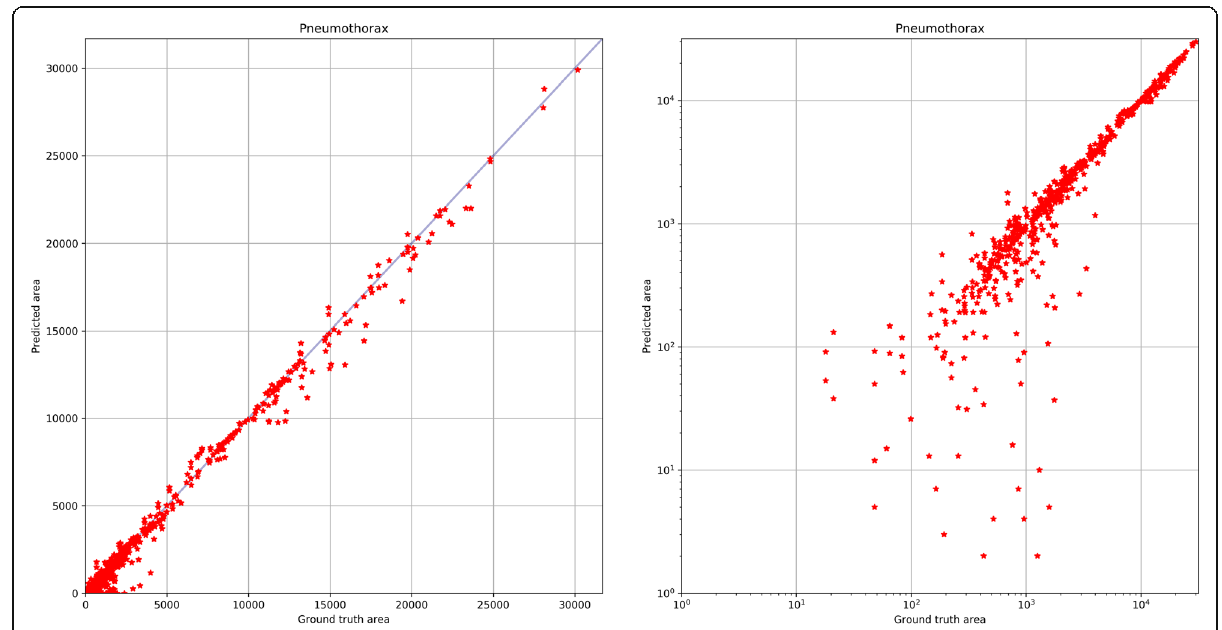
Fig. 6 Correlation of predicted and manually assessed pneumothorax areas. Linear scale (left) and log-log scale (right)